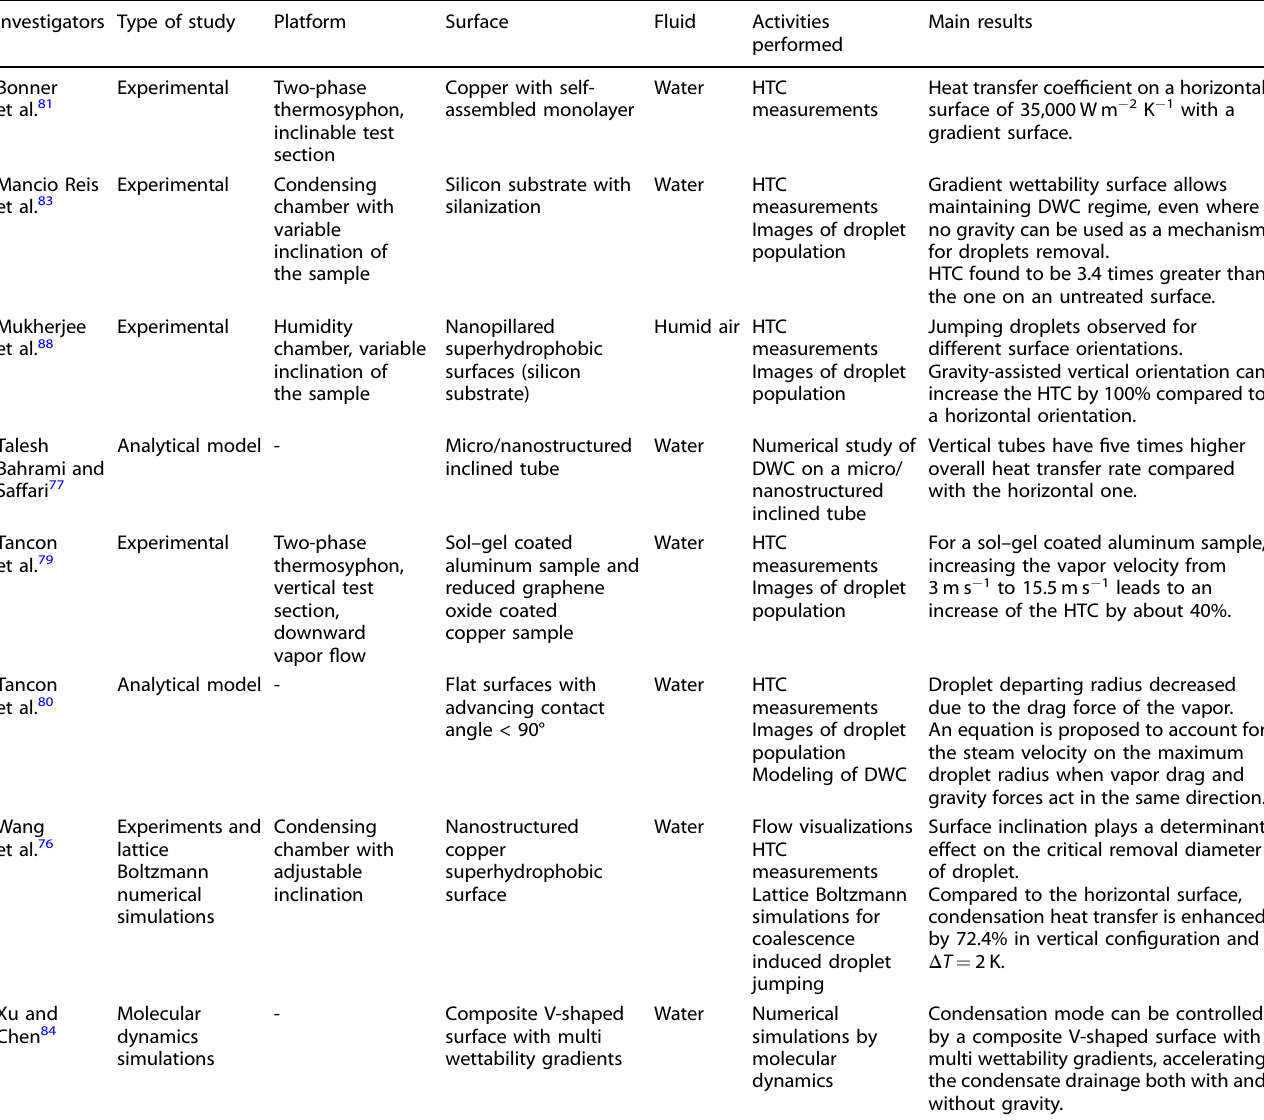
Table 3. List of available studies that address the gravity effect during